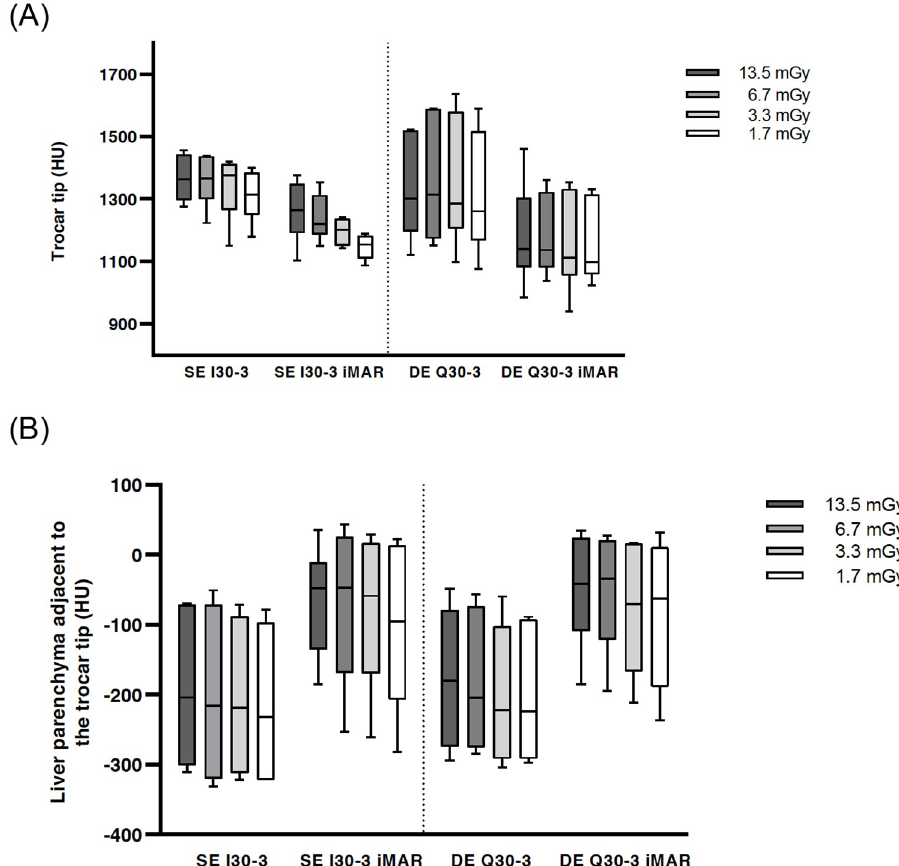
Fig 3. Boxplot of HU values at the trocar tip. No significance between DE vs. SE: I30-3 vs. Q30-3 and I30-3 iMAR vs. Q30-3 iMAR (a). Boxplot of HU values of liver parenchyma adjacent to the trocar tip showing significant metal artifact reduction with iMAR for SE and DE (b).